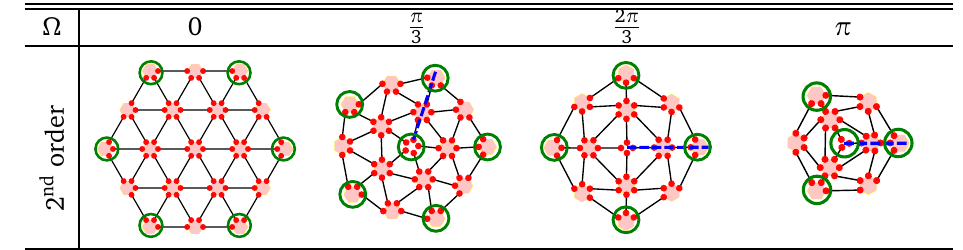
Figure 9: Unique decoration patterns of a sixfold rotation symmetric lattice without disclination ( Ω = 0) and with disclination of Frank angle Ω (cid:54) = 0: decorations with second-order topological phases of (cid:90) topological charge. Symbols and colors are as 2 in Fig.